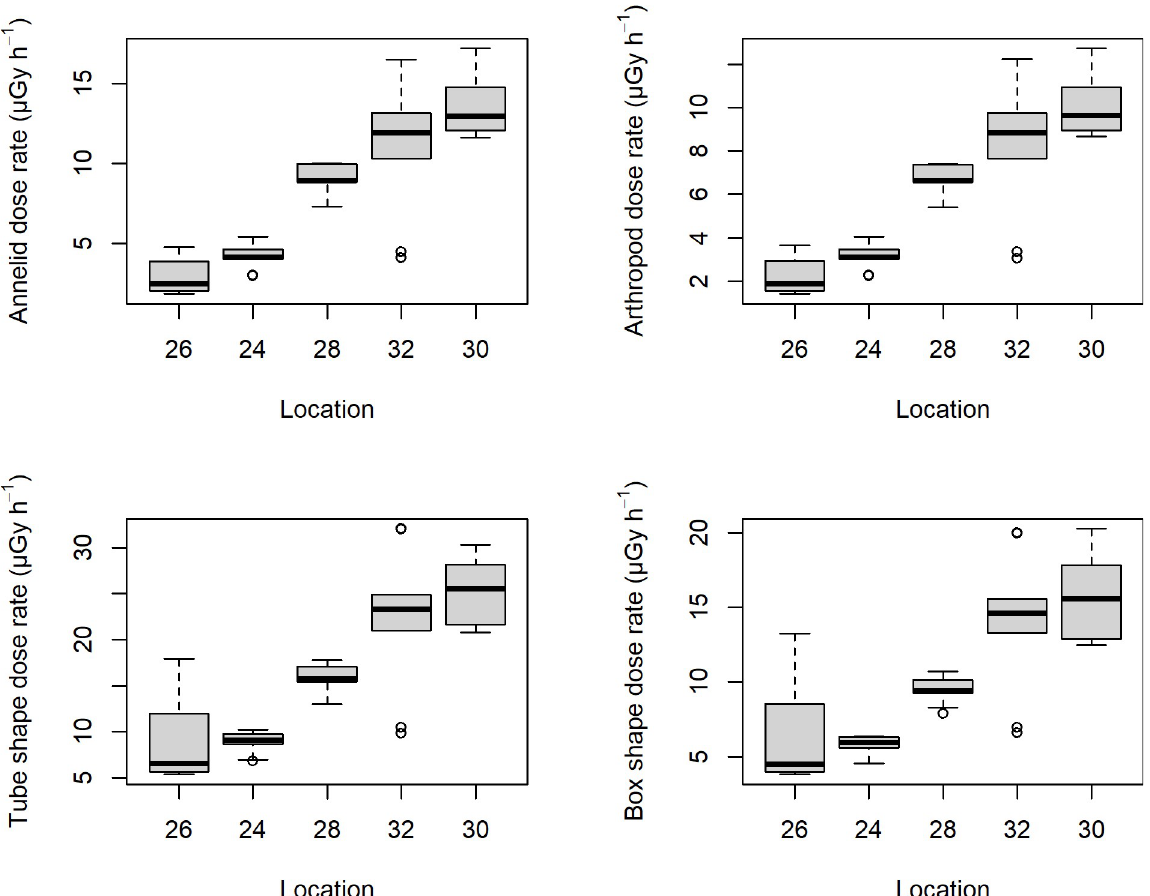
Fig 12. Boxplots of the total dose rate among localities for the four organisms modelled in ERICA tool. comparison, within quartets, pairs of litterbags with oven-dried litter with either coarse or fine mesh differed with from 0.1 to 1.7 grams litter loss (d.w., loss mean: 0.8, SD: 0.4) while pairs of